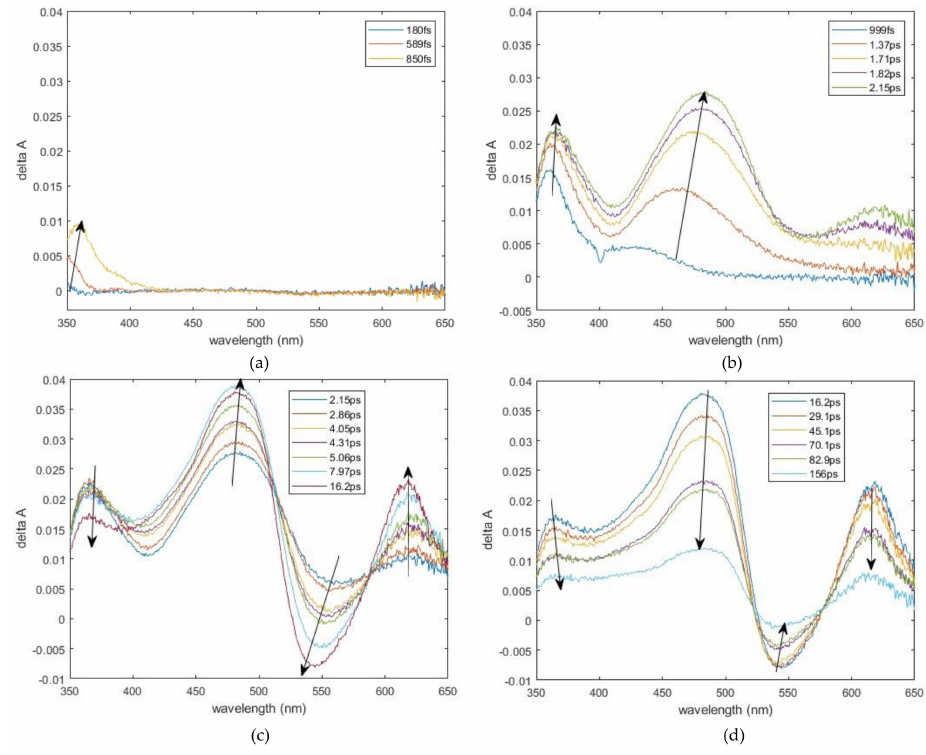
Figure 1. Transient UV-vis absorption spectra produced by fs laser excitation of 1b in acetonitrile ( λ max = 266 nm) with different time frames: ( a ) <1 ps; ( b ) 1–2 ps; ( c ) 2–16 ps; and ( d ) 16–156